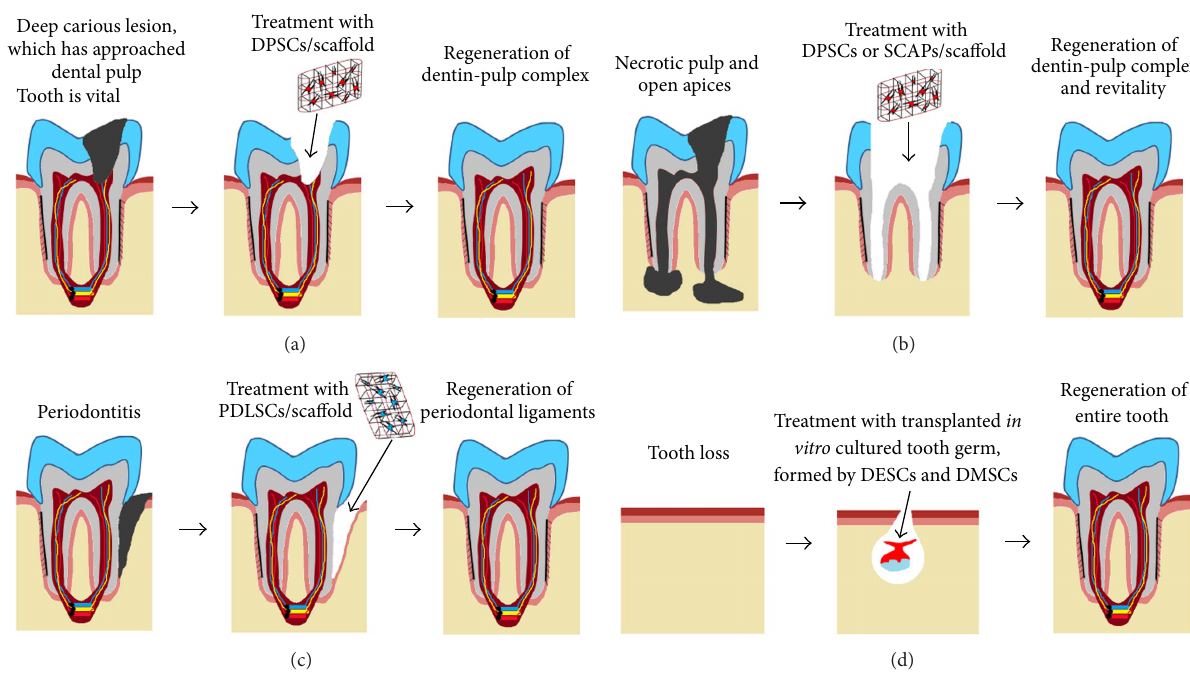
Figure 3: Schematic representation of different stem cell-based approaches for partial or whole tooth regeneration after pathologies and tooth loss using transplantation of tooth stem cells combined with scaffolds. The various dental pathologies: (a) carious lesion, (b) necrotic pulp, (c) periodontitis, and (d) tooth loss. DPSCs, dental pulp stem cells; PDLSCs, periodontal ligament stem cells; SCAP, stem cells from the apical part of the papilla; DESCs, dental epithelial stem cells; DMSCs, dental mesenchymal stem